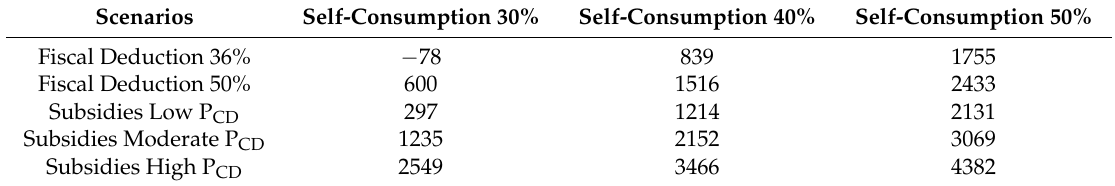
Table 7. NPV in alternative scenario (p s = 7 cent € /kWh). Data expressed in € .